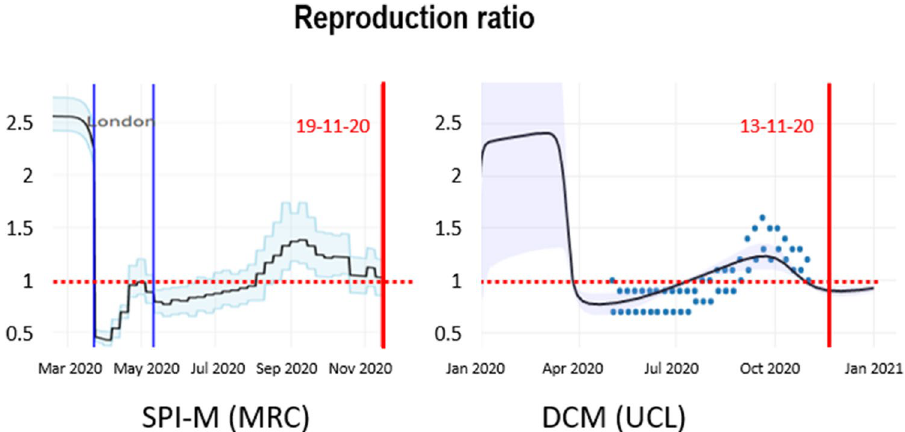
Figure 6. Estimates of the reproduction ratio from the MRC Biostatistics Unit (left panel) and dynamic causal modelling (right panel). The black lines correspond to the best (posterior) expectations and the shaded area correspond to credible intervals. The blue dots superimposed over the dynamic causal modelling estimates report the ranges of consensus values reported by the government 22 . These have been plotted 2 weeks before the end date of the reporting period for each pair. The vertical red lines indicate the date of estimation in mid-